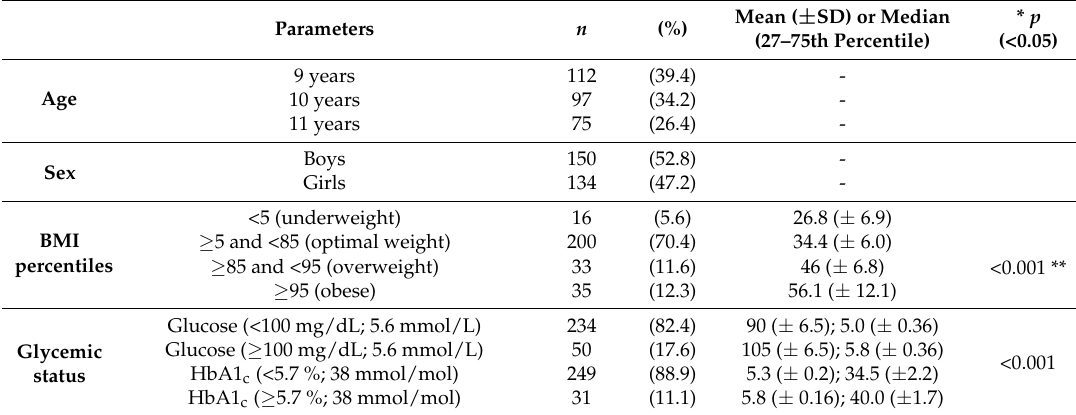
Table 1. Characteristics of the study population ( n =